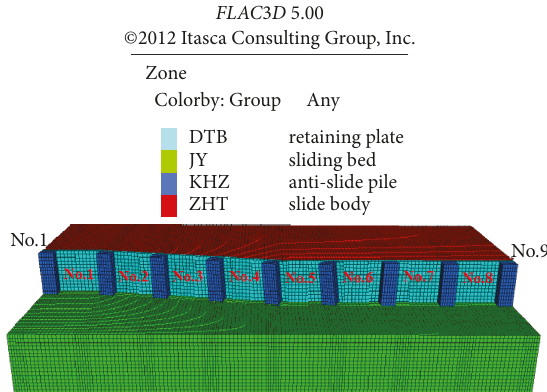
Figure 9: Model of 10 ° polyline pile